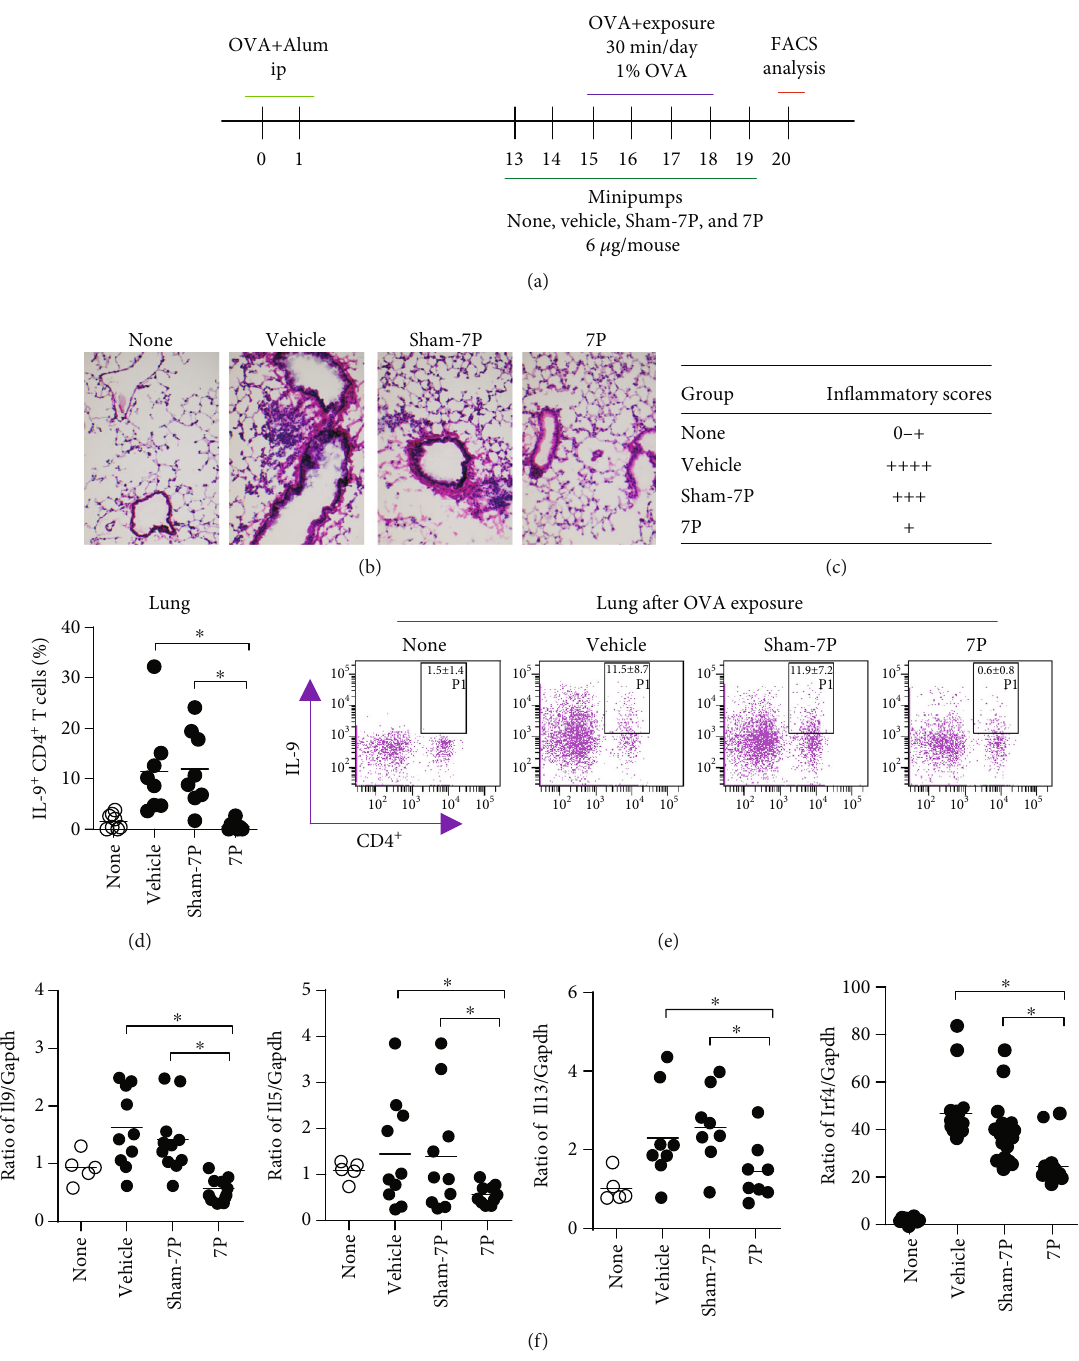
Figure 1: The 7-amino acid peptide (7P) dramatically inhibits Th9 cell di ff erentiation during allergic lung in fl ammation after ovalbumin (OVA) sensitization and exposure in vivo . (a) C57BL6J mice ( n = 24 each) were sensitized with OVA in adjuvant. Mice were exposed to OVA for inhalation 14 – 21 days later for 4 consecutive days. Mice were implanted with minipumps from days 13 – 19; 7P and sham-7P mice were given 6 μ g/mouse. (b) Lung tissue sections were stained with hematoxylin and eosin (H&E) and visualized by light microscopy (original magni fi cation 3100). (c) Pathological scoring was done on a traditional 1 – 4 scale (minimal, mild, moderate, marked) by two pathologists. The in fl ammatory score was counted by fi ve slides of each normal, 7P-treated group, sham-7P, and vehicle group. (d) The percentages of IL-9 + CD4 + T cells in lung tissue from 7P vs. sham-7P and vehicle minipumped mice were analyzed by fl ow cytometry 48h after the last OVA exposure. (e) Flow cytometry scattergrams of IL-9 + CD4 + T cells in the lung. (f) Il9 , Il5 , Il13 , and Irf4 mRNA in the lung were examined by real-time PCR ( ∗ p < 0 : 05 , n = 12